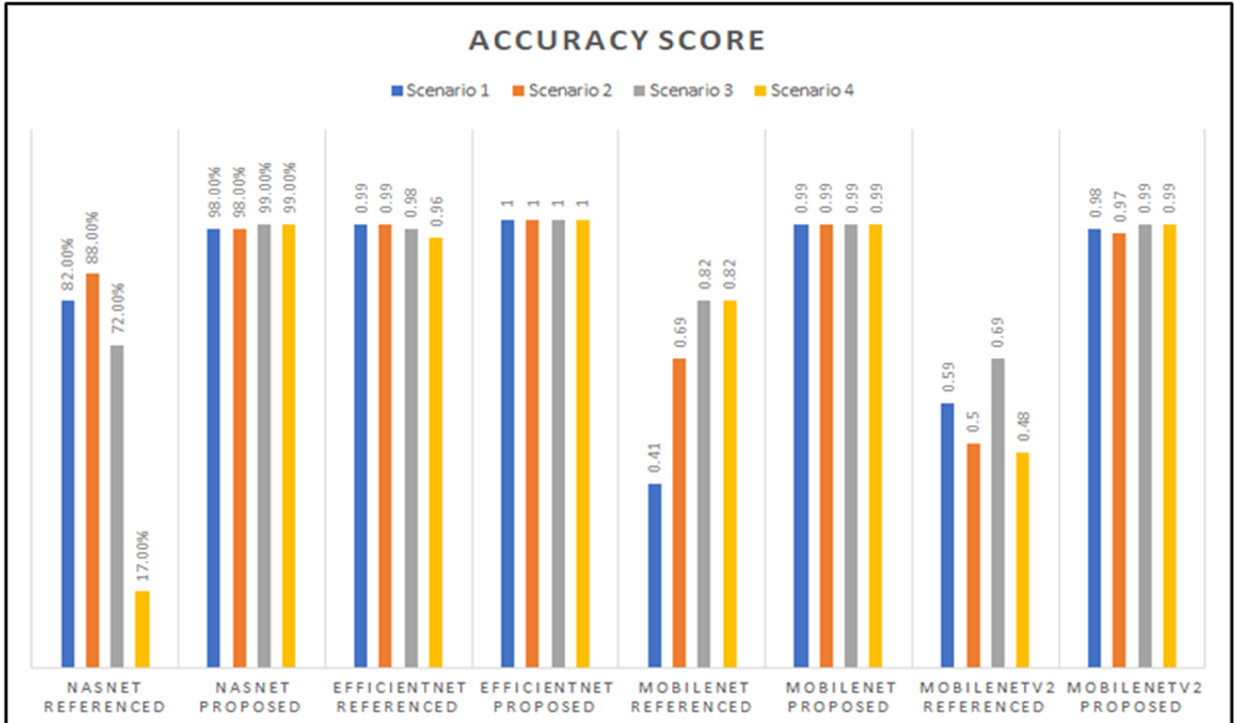
Figure 12. Graphed results of accuracy scores for all models developed.